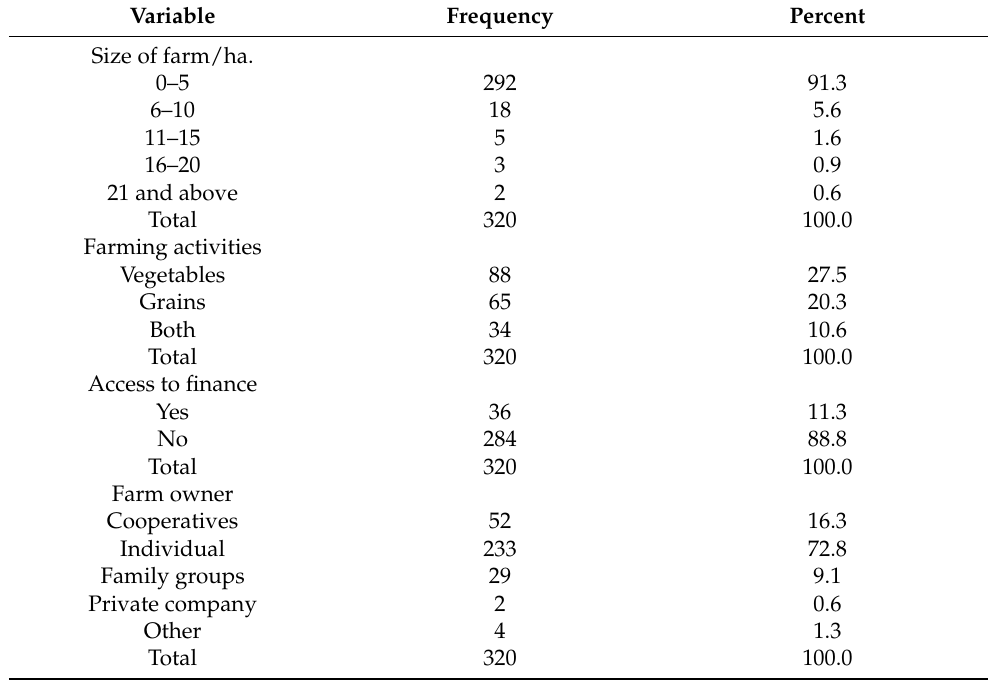
Table 3. Socio-economic characteristics of the smallholder farmers (n =